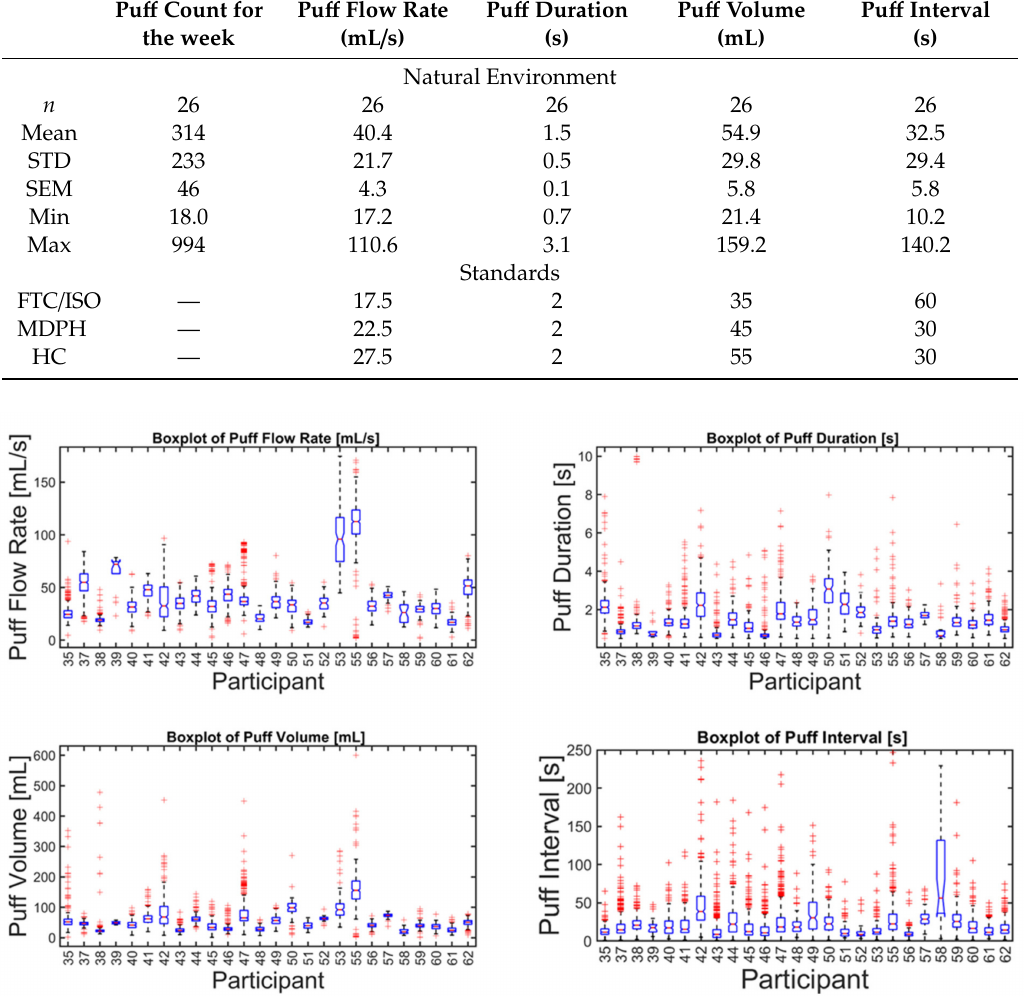
Table 1. Cohort mean descriptive statistics compared to currently available standards.